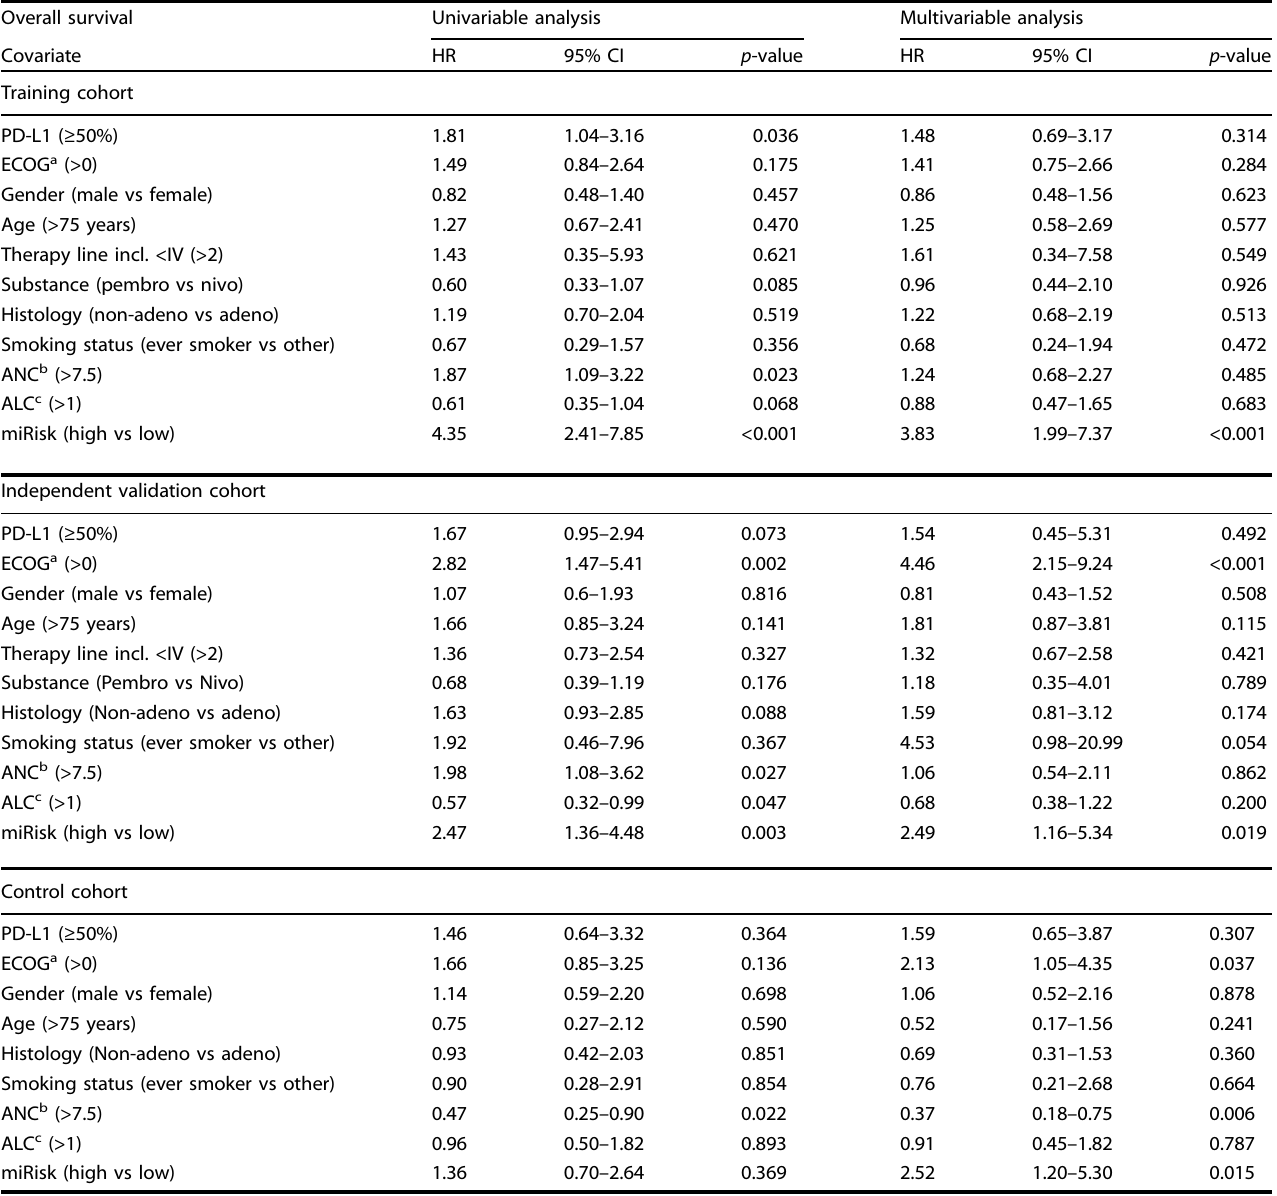
Table 2. Univariable and multivariable Cox regression analysis of miRisk and clinical